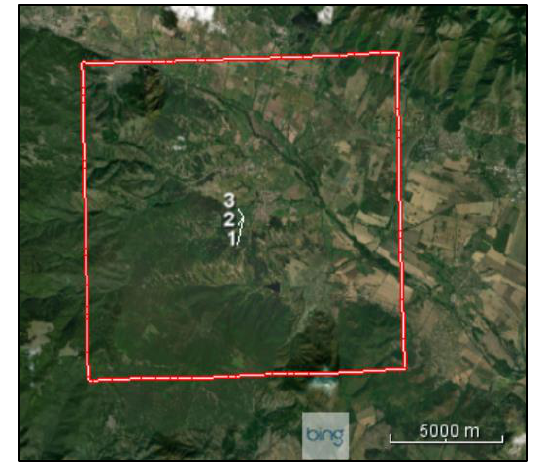
Figure 6. Area of Interest for Sentinel-2 images